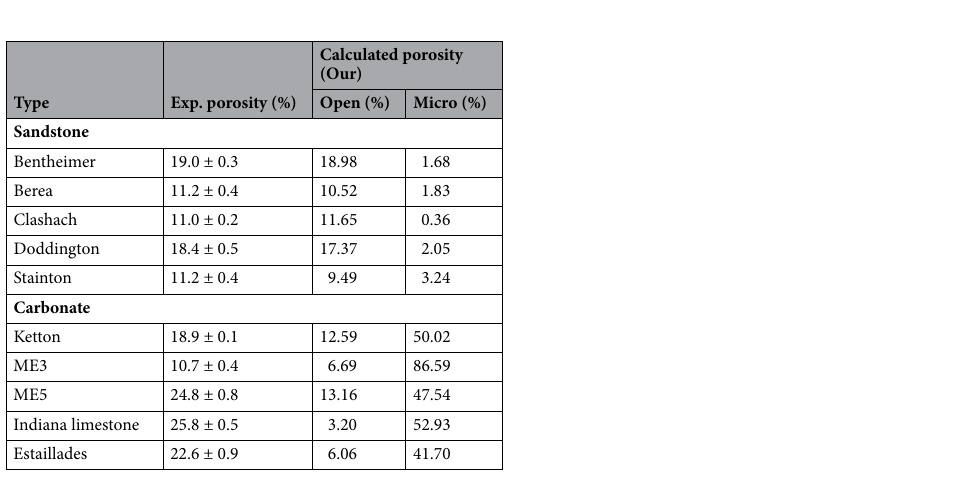
Figure 15. A full-size middle cut of 5 carbonate images and their corresponding three-phase segmentation by our model.